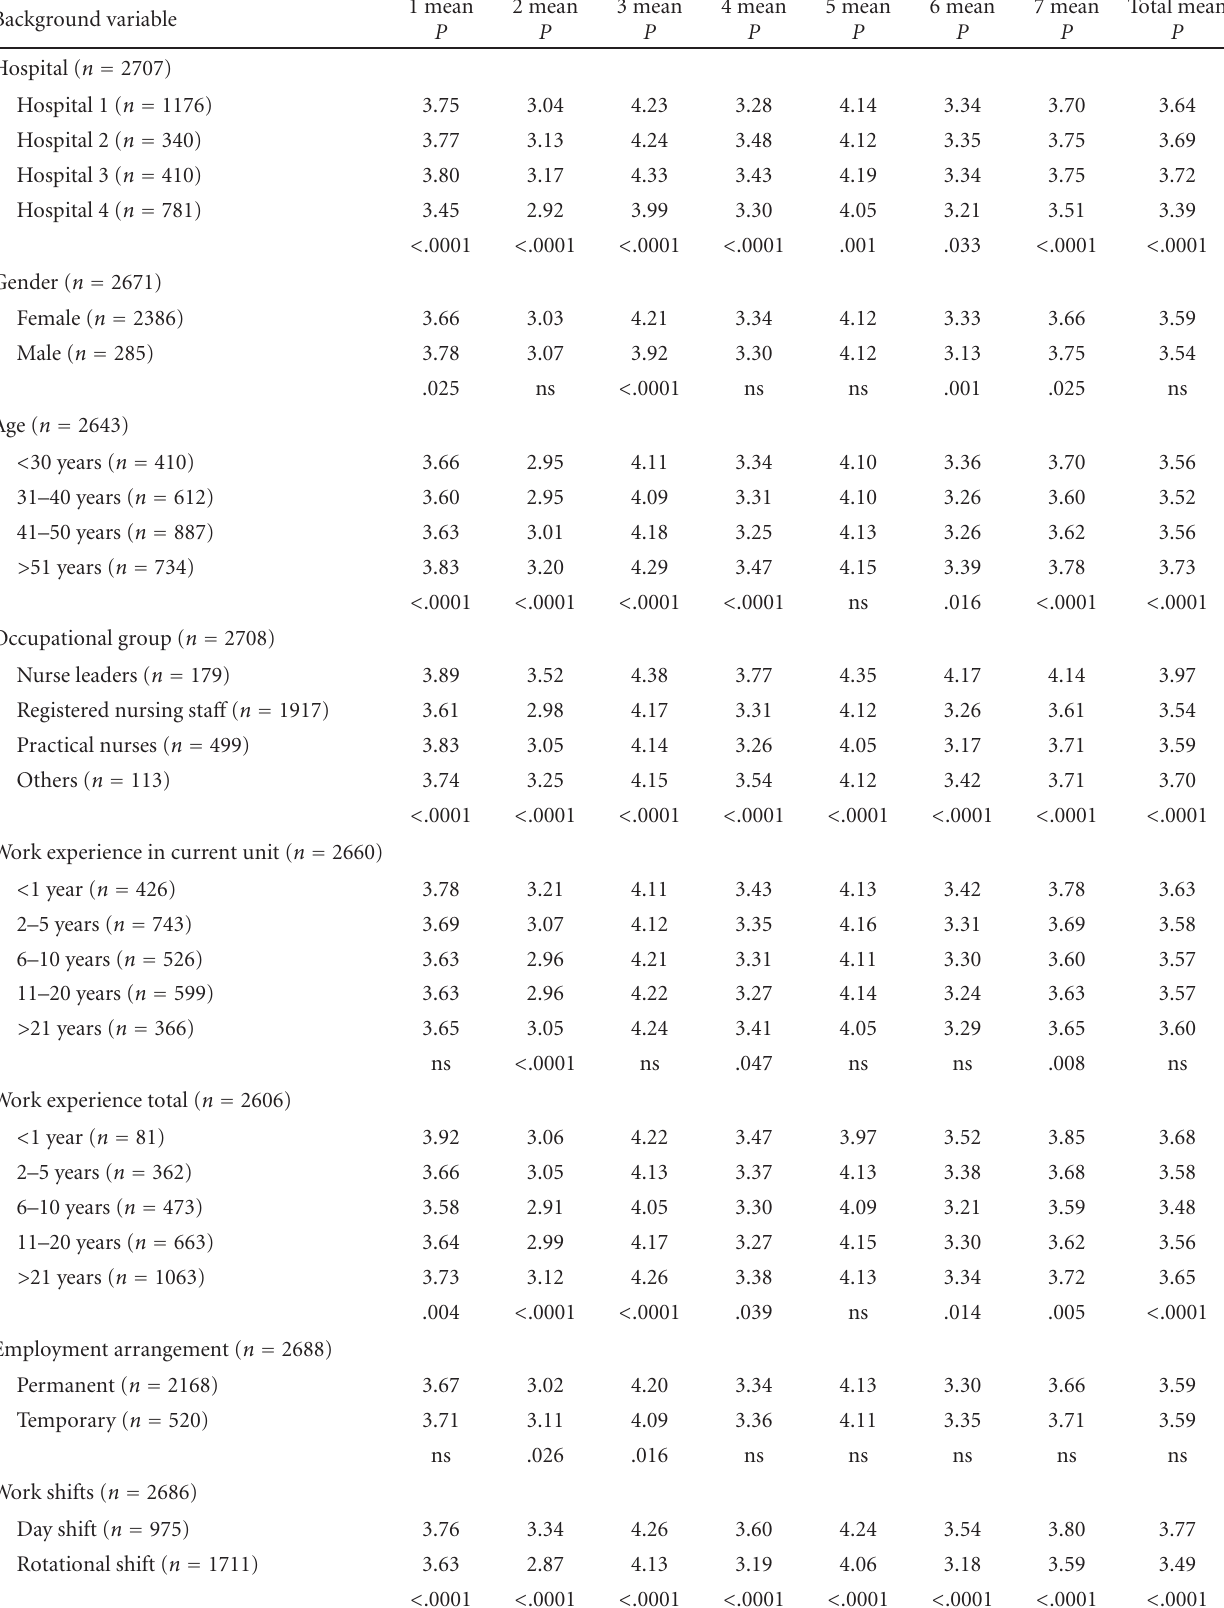
Table 3: Relationships between demographic variables and job satisfaction ( N =